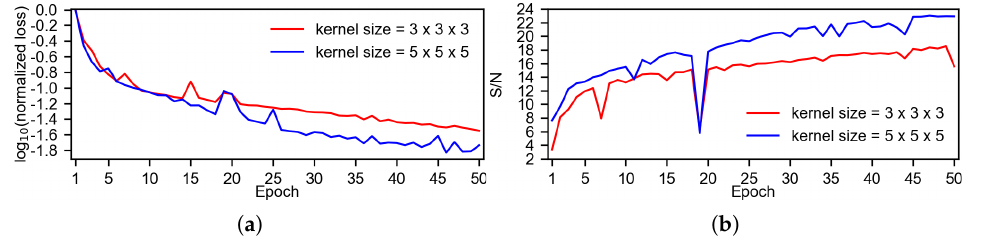
Figure 13. ( a ) Variation in log (normalized loss) with epoch for 3D CNN’s training process using 10 different kernel sizes. ( b ) Variation of the S/N values of the DL prediction result with the number of epochs for 3D CNN’s validation processes with different kernel sizes.